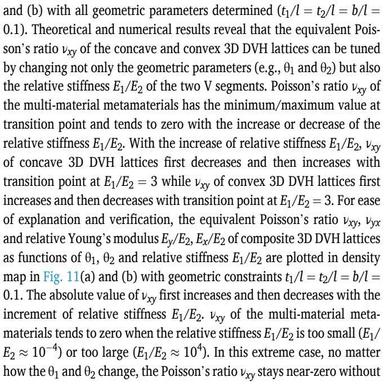
Theoretical analysis of the influence of geometric parameters on elastic constants of 3D DVH lattices with single constitute material, (a) equivalent Poisson's ratio and relative Young's modulus of 3D DVH lattices as functions of θ1 and θ2 (t1/l = t2/l = b/l = 0.1), (b) equivalent Poisson's ratio and normalized Young's modulus of 3D DVH lattices as functions of θ2(t1/l = t2/l = b/l = 0.1), (c) equivalent Poisson's ratio and normalized Young's modulus of 3D DVH lattices as functions of relative thickness t1/